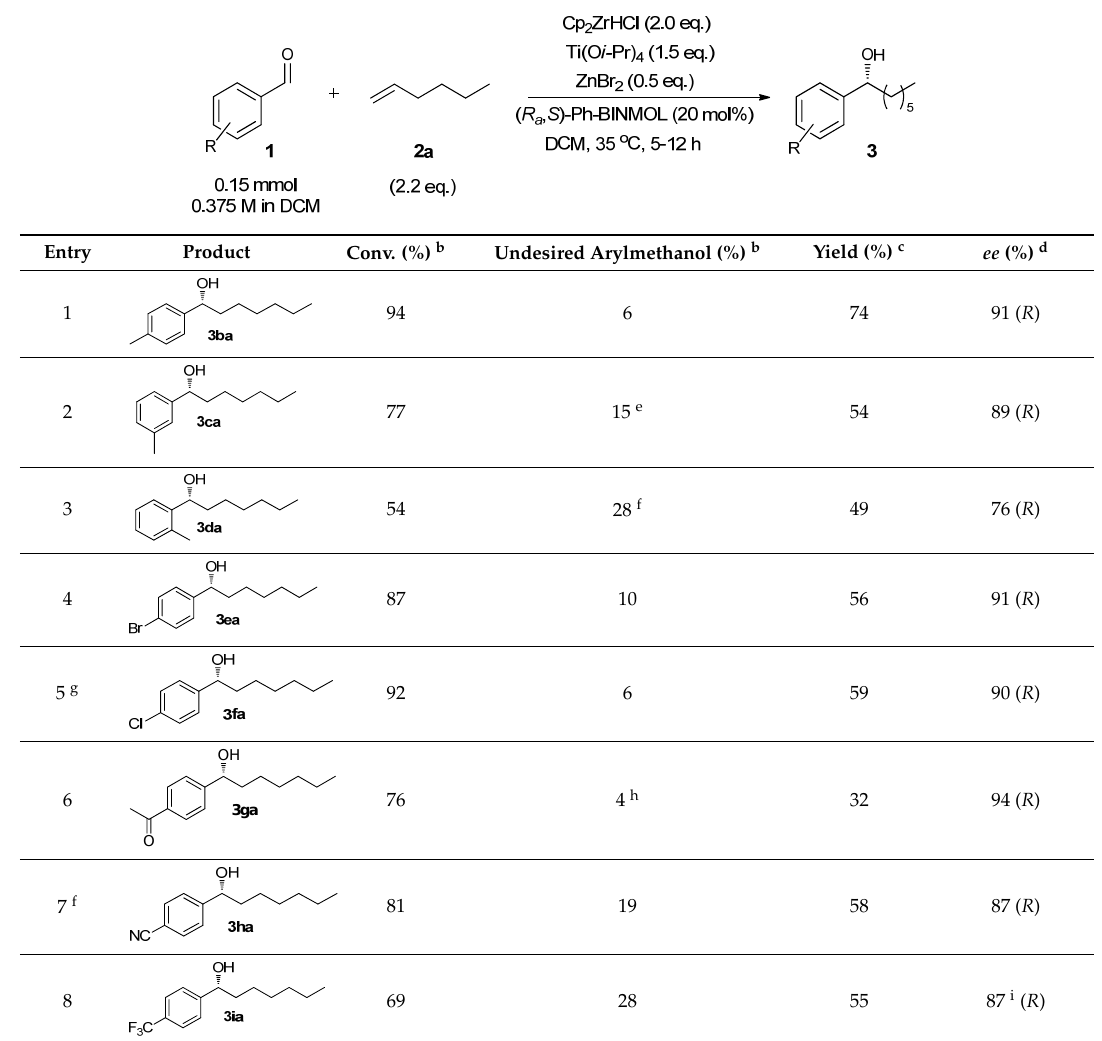
Table 2. Enantioselective catalysed addition of 1 ‐ hexene ( 2a ) to aromatic aldehydes—Scope of the reaction a .